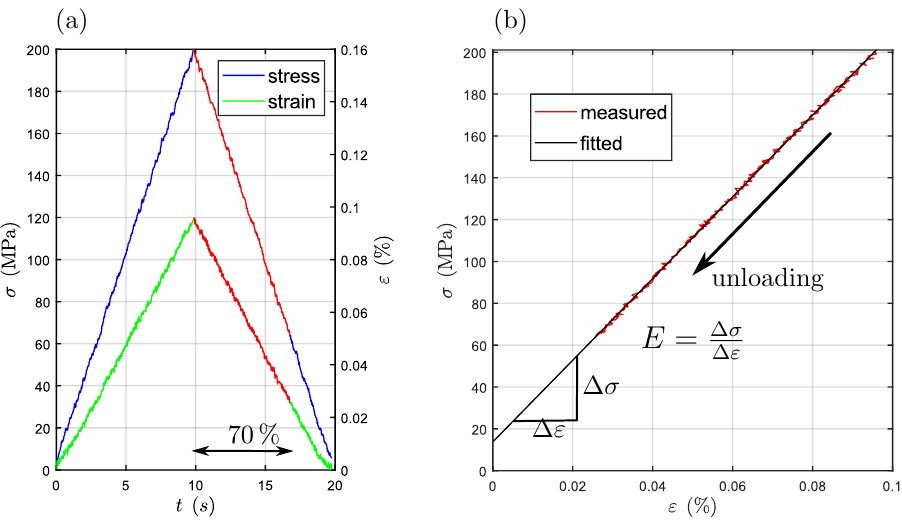
Figure 3. ( a ) Stress and strain plotted over time in a measurement cycle. ( b ) Evaluation of the Young’s modulus from a single measurement